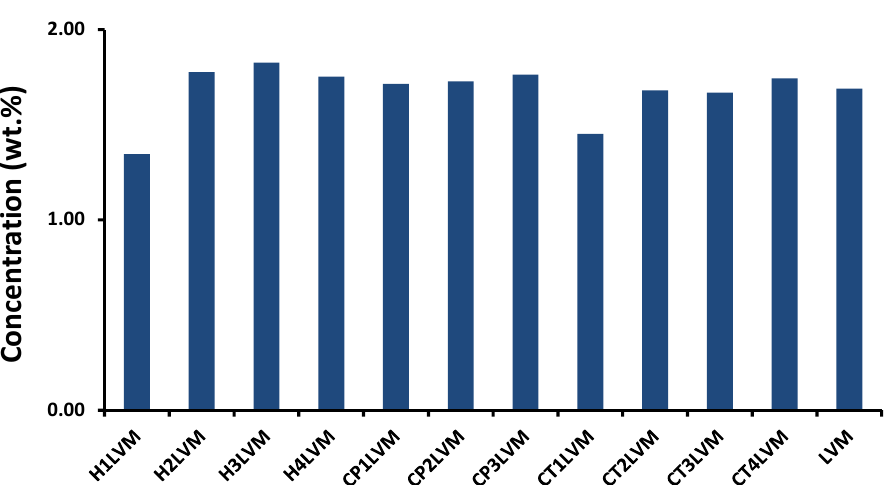
Figure 4. The incorporation efficiency of Curcumin with variation of the polymer content in gel microemulsion: H—for LVM with sodium hyaluronate; CP—for LVM with Carbopol; CT—for LVM with chitosan. For details on sample content, see Table 1.